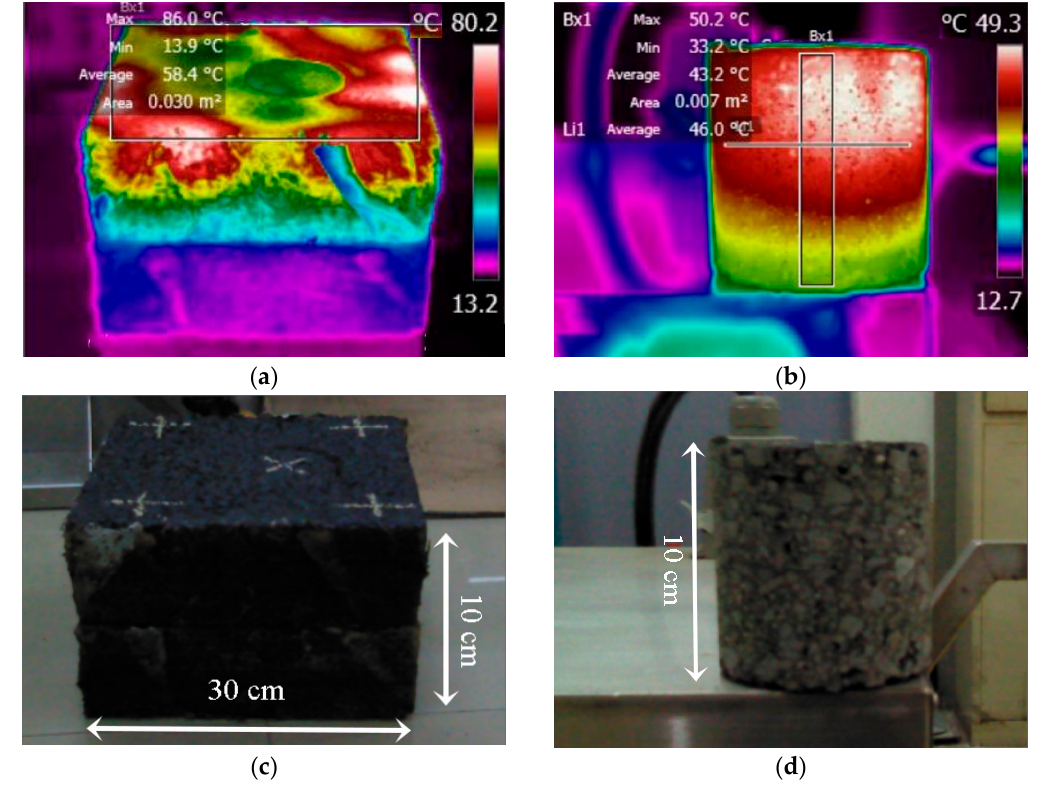
Figure 8. Infrared images of slab and core after heating for 15 min with improved microwave machine. ( a ) Surface temperature profile of slab after heating; ( b ) Vertical temperature profile of core after heating; ( c ) Slab sample; ( d ) Core sample.